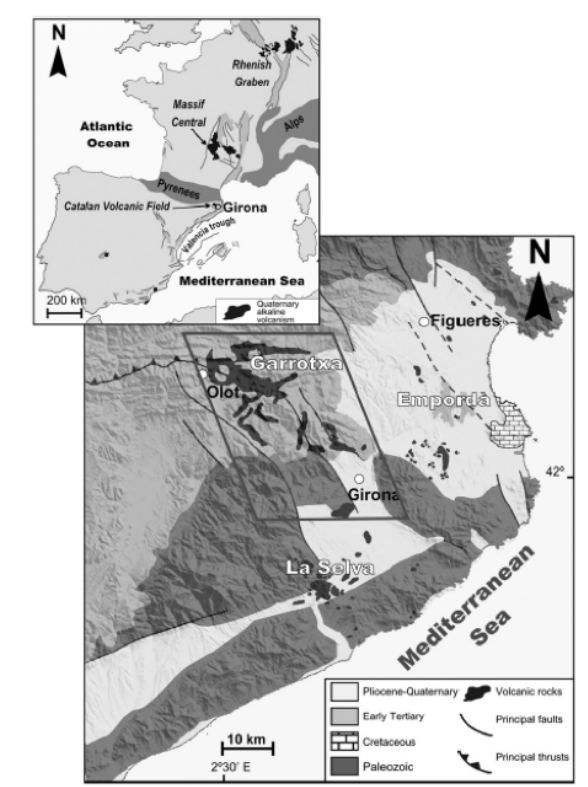
Fig. 4. Geographical and geological settings of the La Garrotxa vol- canic field (Martí et al.,